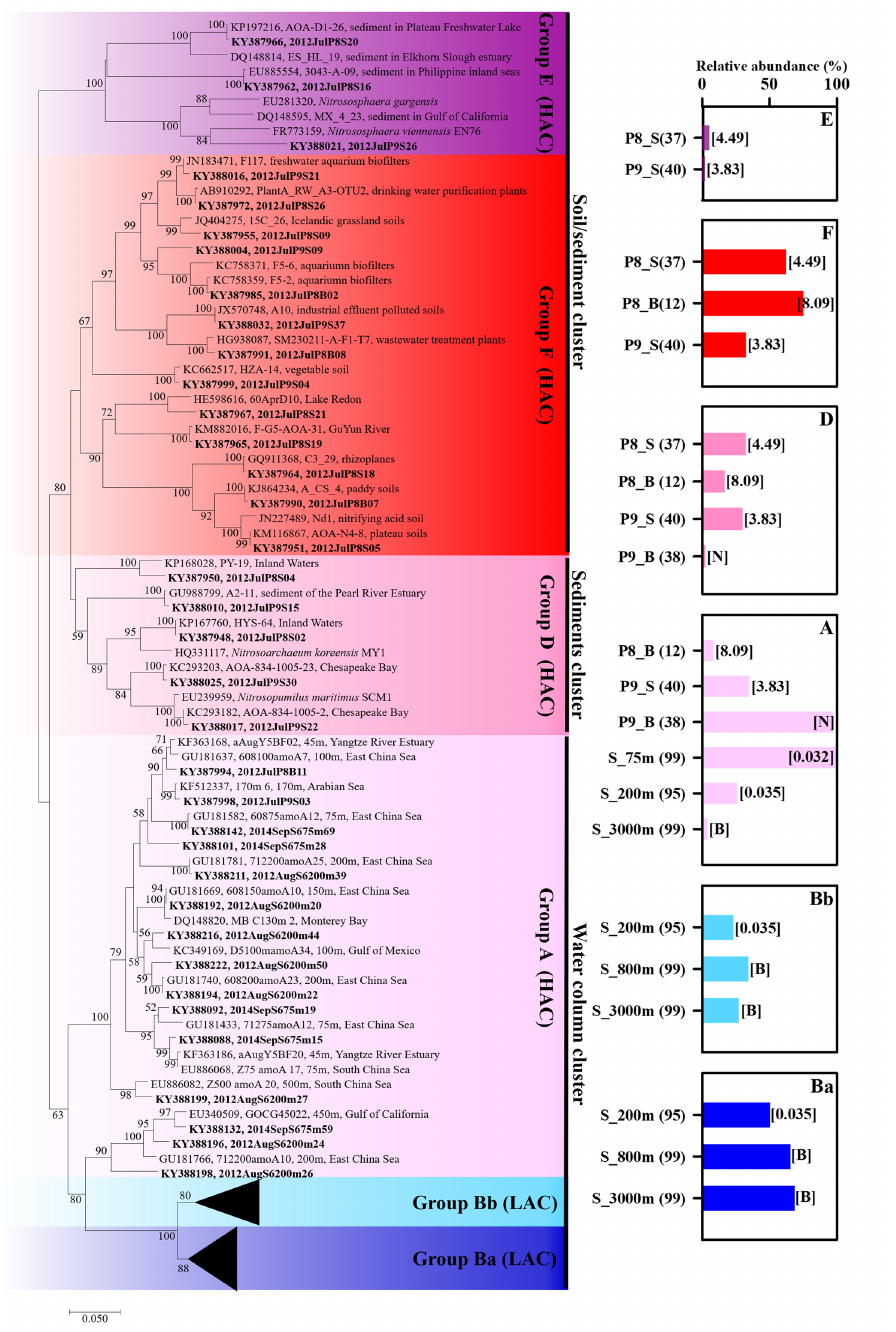
Figure 3. Unrooted neighbor-joining (NJ) phylogenetic tree of the archaeal amo A gene sequences. Clone sequences from this study are shown in bold, and sequences sharing 95% DNA identity are grouped. GenBank accession numbers are shown. Groups A, Ba, Bb, and D were defined in Nunoura et al. (2015); group E was defined in Nunoura et al. (2013); and group F is defined in this study. The relative abundance of clones retrieved for each library in the six subgroups is indicated by a bar. Total number of clones for each library is shown in parentheses. Location of sites P8 and P9 (S and B indicate surface and bottom waters, respectively) and SEATS (S) are shown in Fig. 1. Ammonium concentrations are shown in square brackets. Phylogenetic relationships were bootstrapped 1000 times, and bootstrap values greater than 50% are shown. The scale bar indicates 5% estimated sequence divergence. HAC, high-ammonia cluster; LAC, low-ammonia cluster. N, not measured; B, below detection